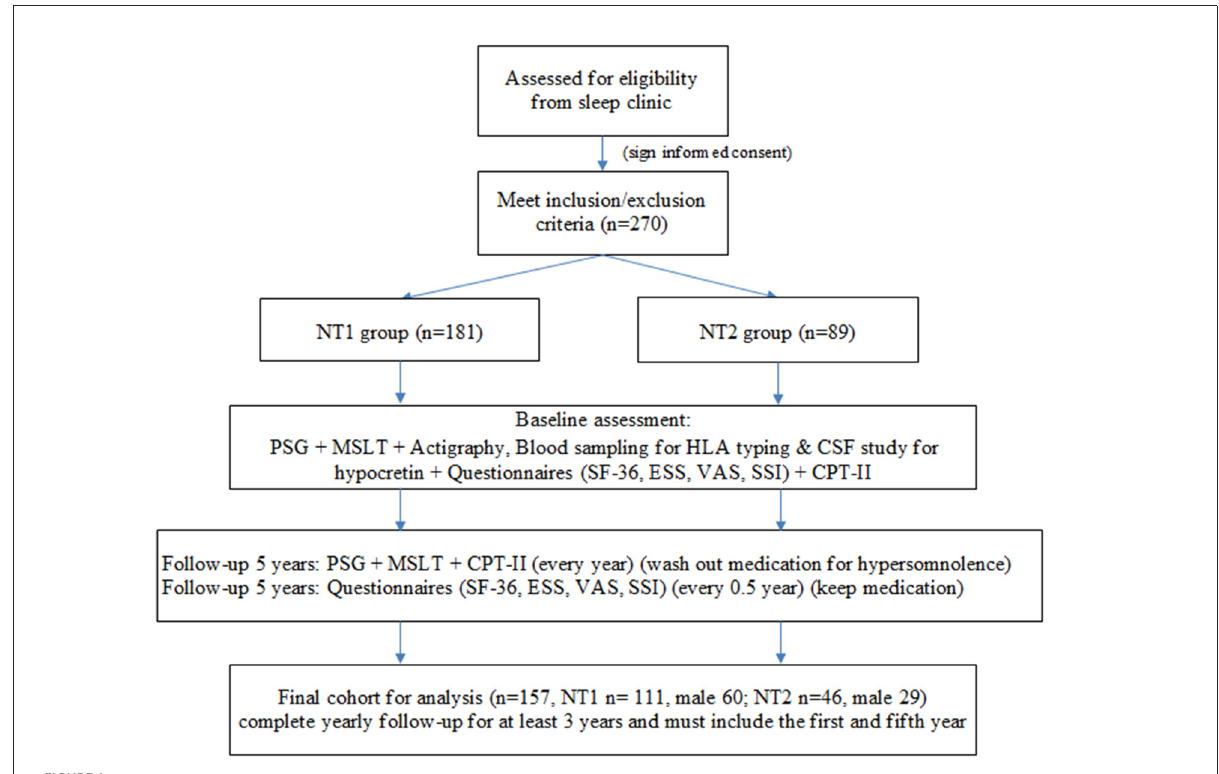
FIGURE1 Study flow chart. NT1, type 1 narcolepsy; NT2, type 2 narcolepsy; PSG; polysomnography; MSLT, multiple sleep latency test, CSF; cerebrospinal fluid; SF-36; Short Form 36 Health Survey Questionnaire; ESS; Epworth Sleepiness Scale; VAS; Visual Analog Scale for hypersomnolence;